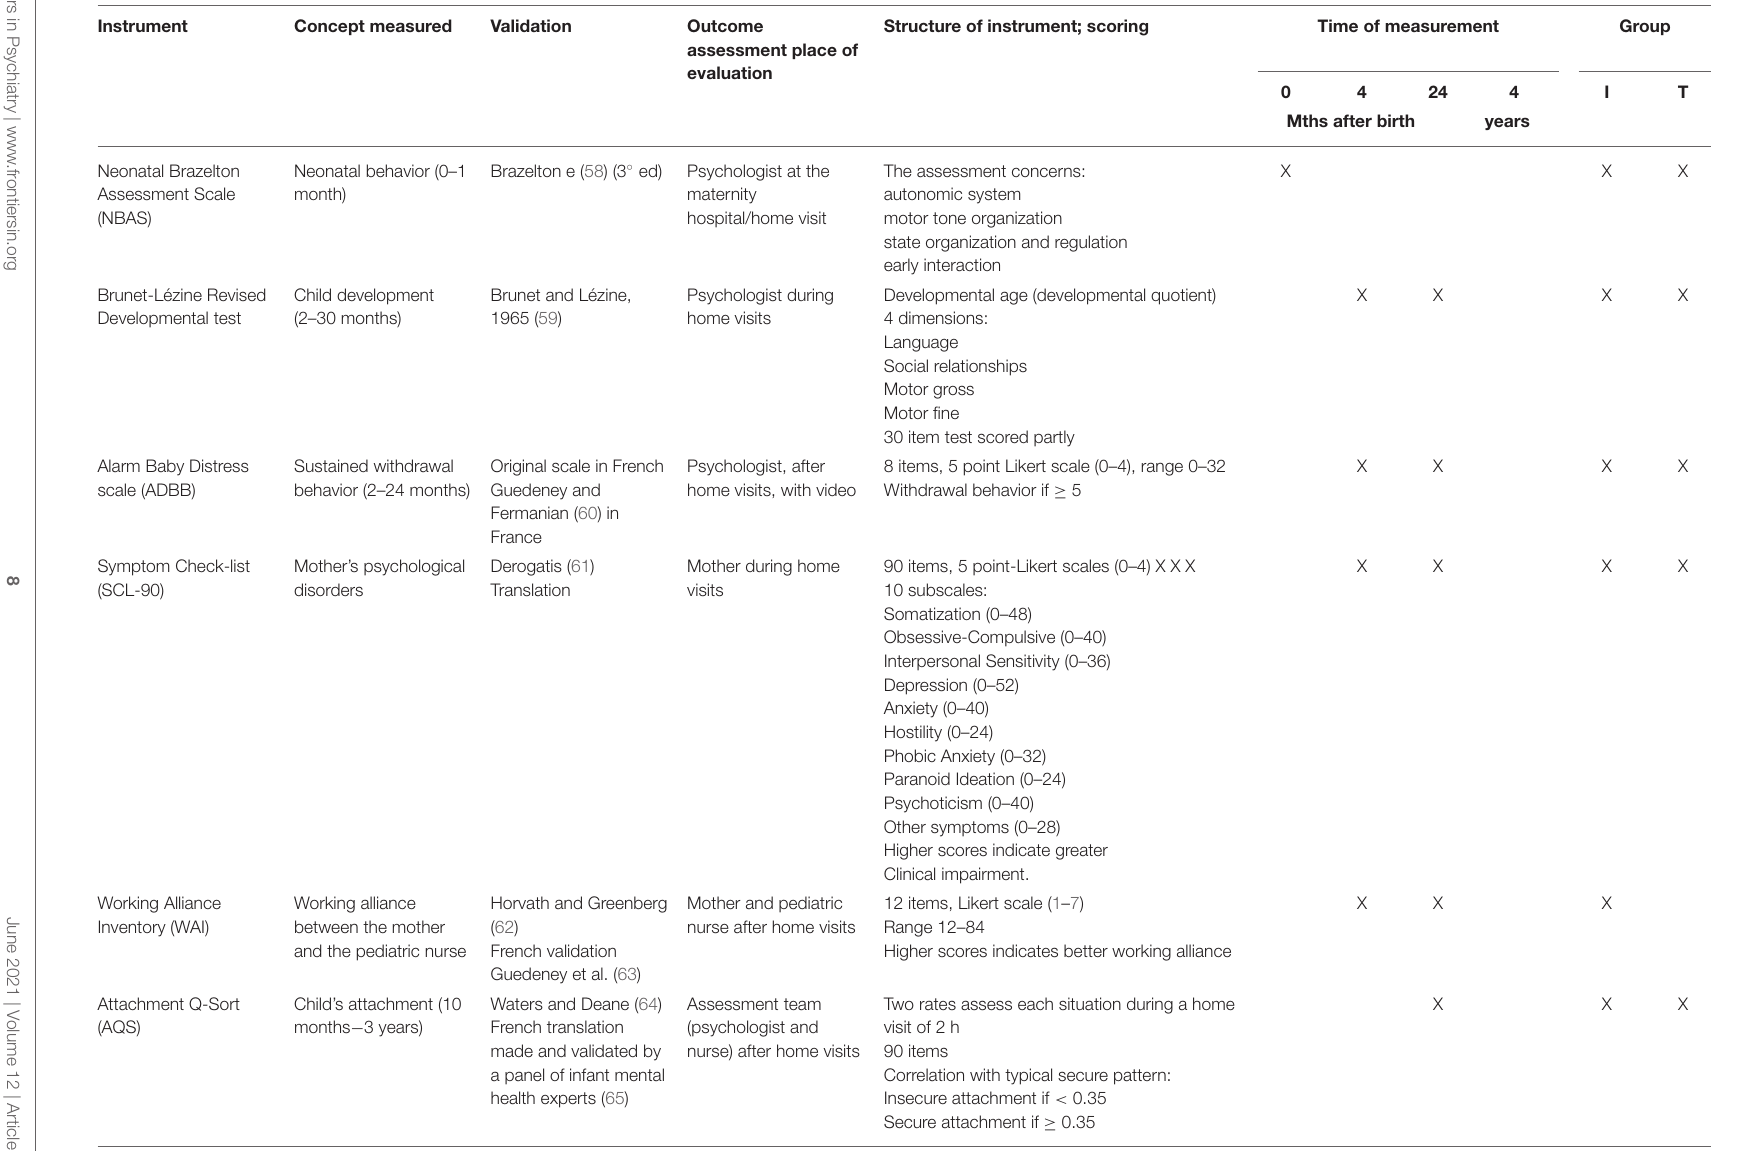
TABLE 3 | Outcome criteria and assessment